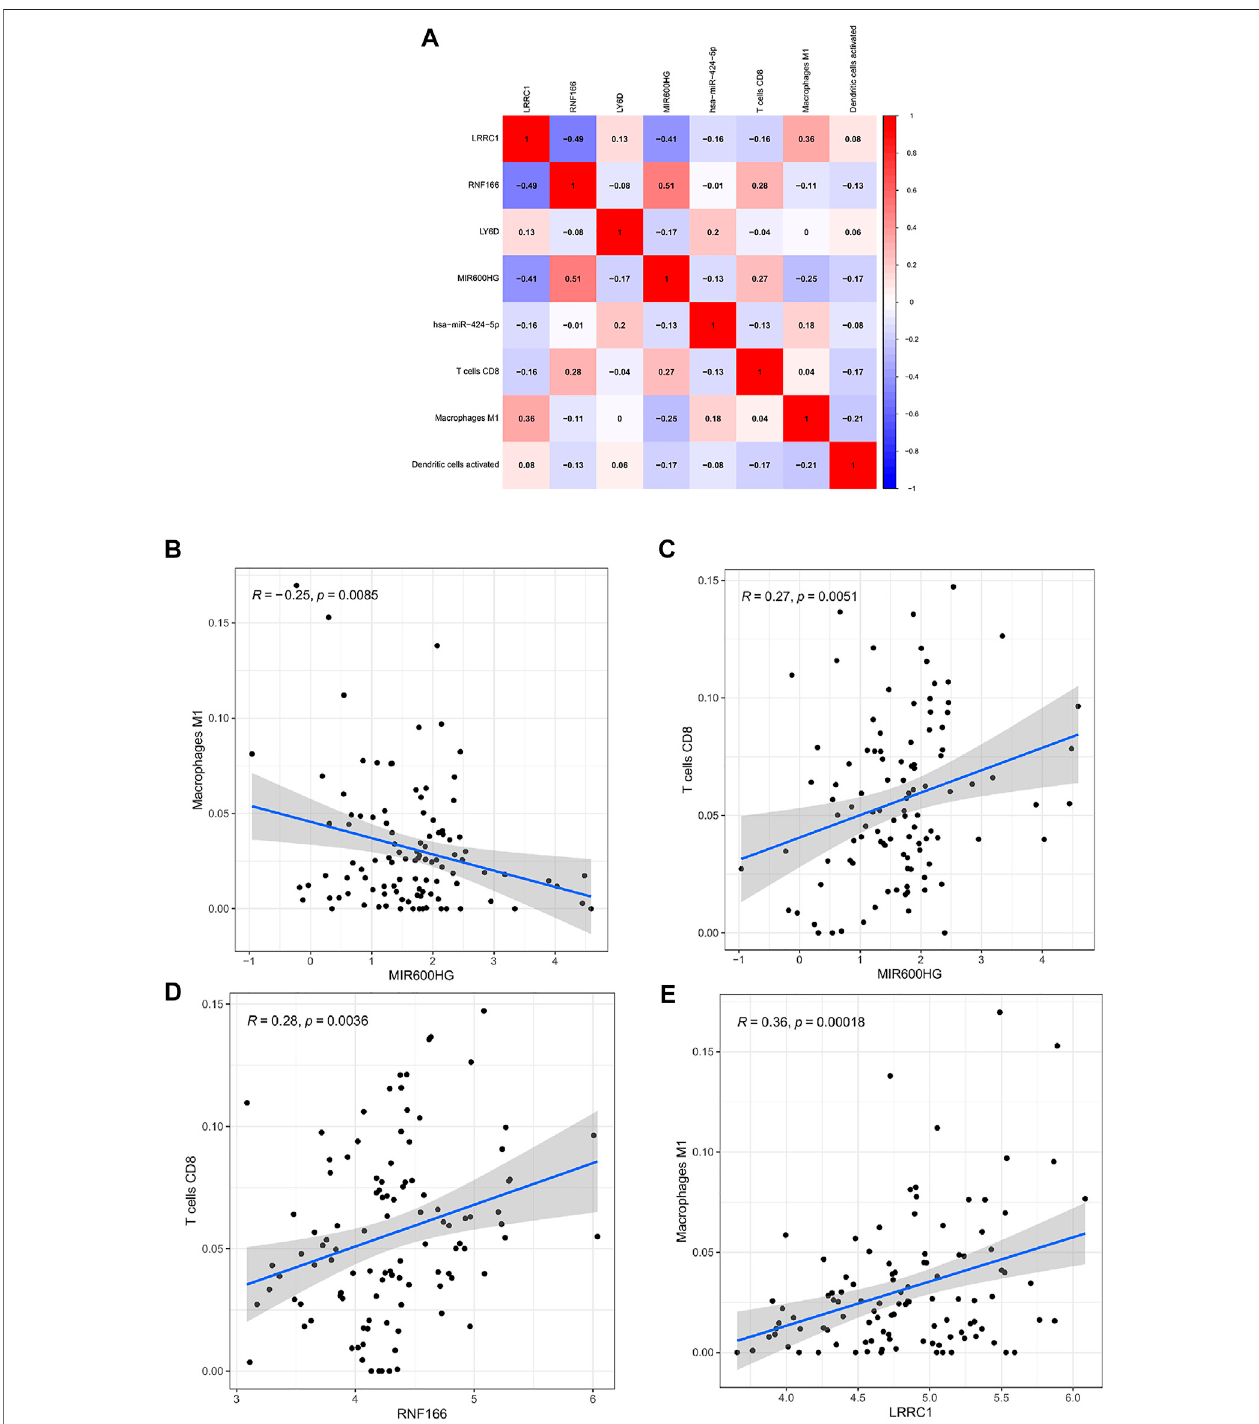
FIGURE 10 | Co-expression patterns among fractions of three immune cells and fi ve hub genes in the ceRNA network (A) ; MIR600HG and M1 macrophages (B) ; MIR600HG and CD8 T cells (C) ; RNF166 and CD8 T cells (D) ; LRRC1 and M1 macrophages (E) .